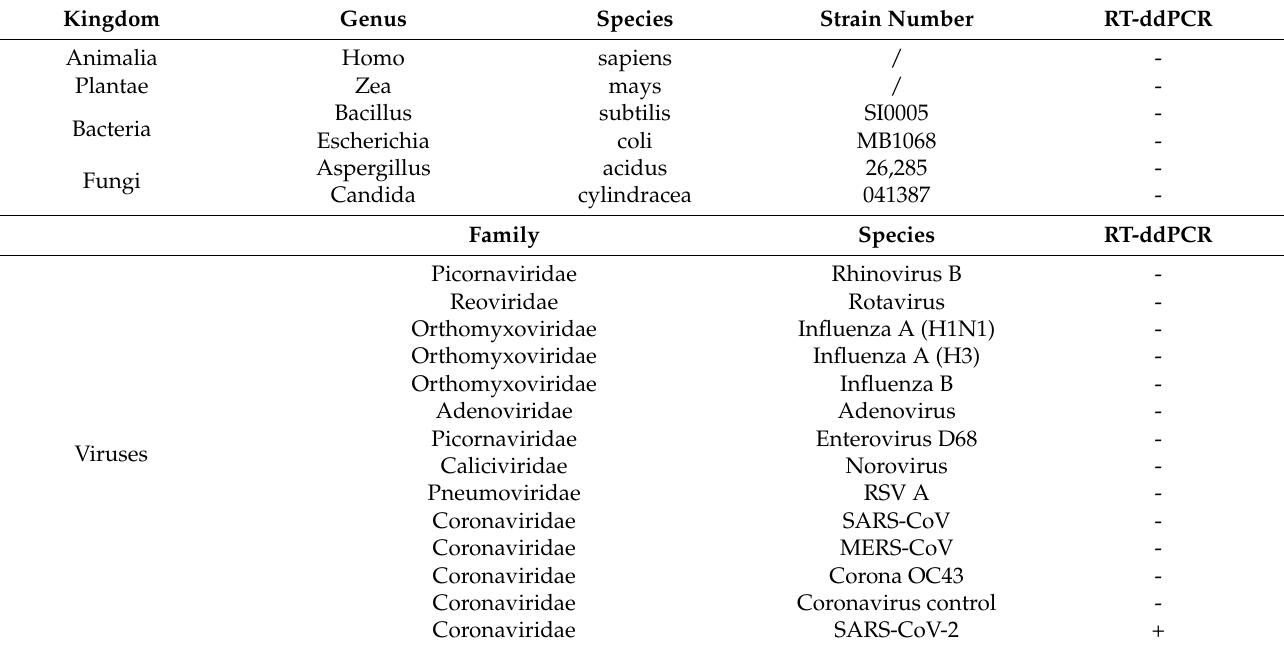
Table 3. Specificity assessment of the developed RT-ddPCR